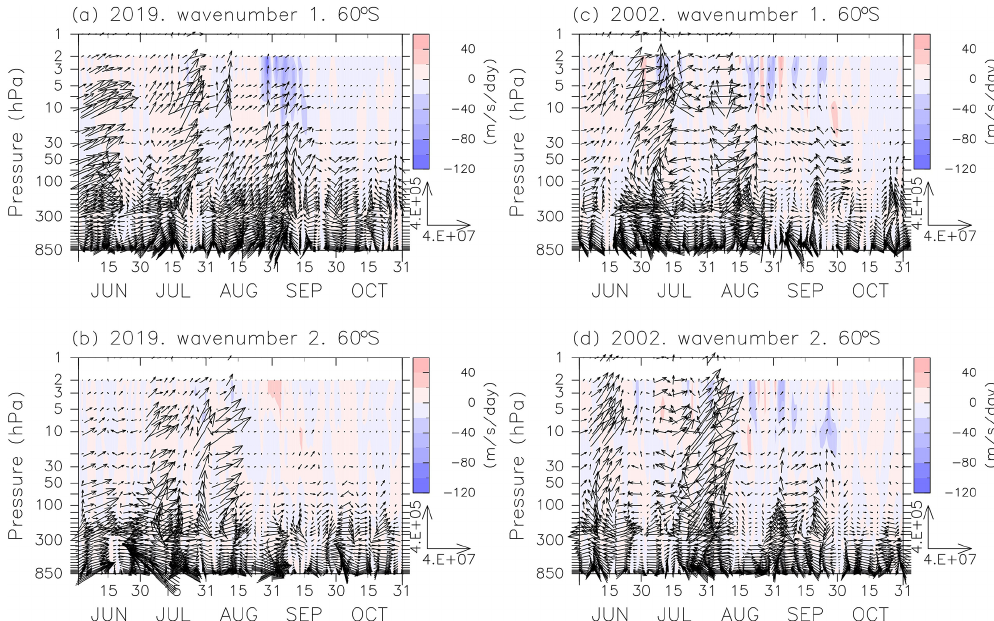
Figure 6. Time–height cross-sections of the E–P flux (kgs − 2 ) (vectors) at 60 ◦ S for zonal wavenumber 1 (a, c) and 2 (b, d) and the wave driving due to its divergence (ms − 1 d − 1 ) (color shading) from 1 June to 31 October in 2019 (a, b) and 2002 (c, d) . E–P flux vectors pointing to the right direction corresponds to poleward. The blue (red) shading denotes the zonal wind deceleration